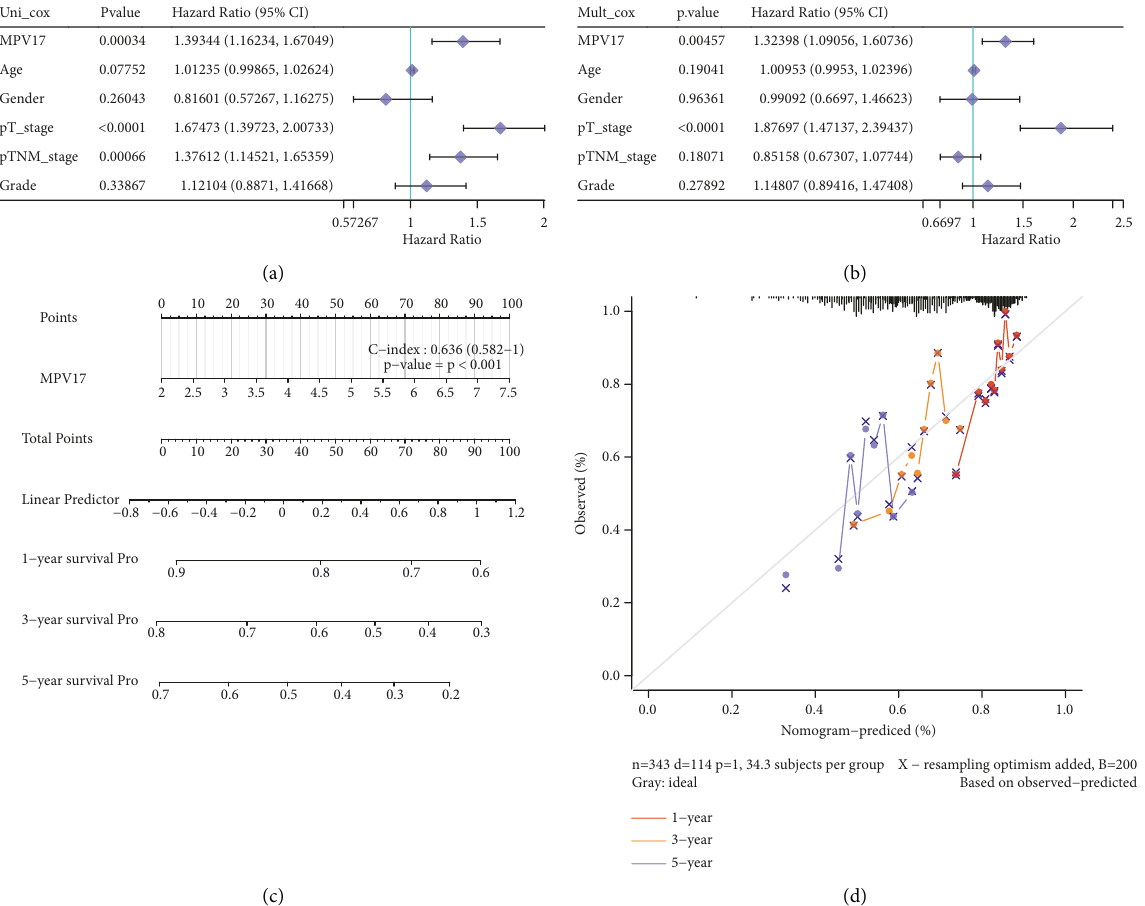
Figure 5: Predictive nomogram analysis of MPV17. (a, b) Cox analysis on MPV17 expression and clinical characteristics in LIHC. (c) Nomogram predicts 1-, 3-, and 5-year overall survival of HCC patients. (d) Calibration curve represents the ideal